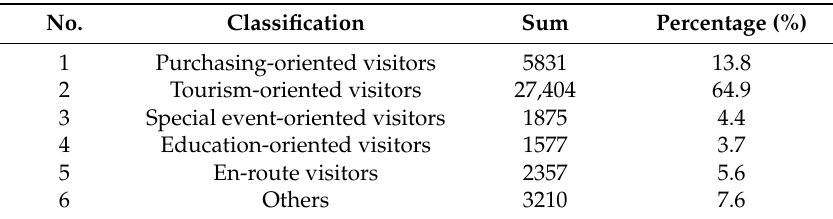
Table 4. Proportion of each classification type.